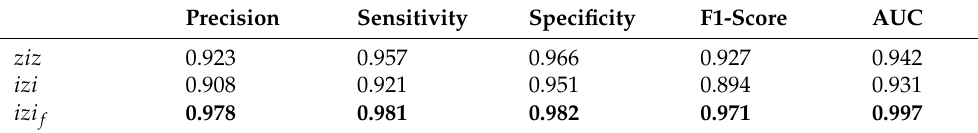
Table 3. Encoder training performance.